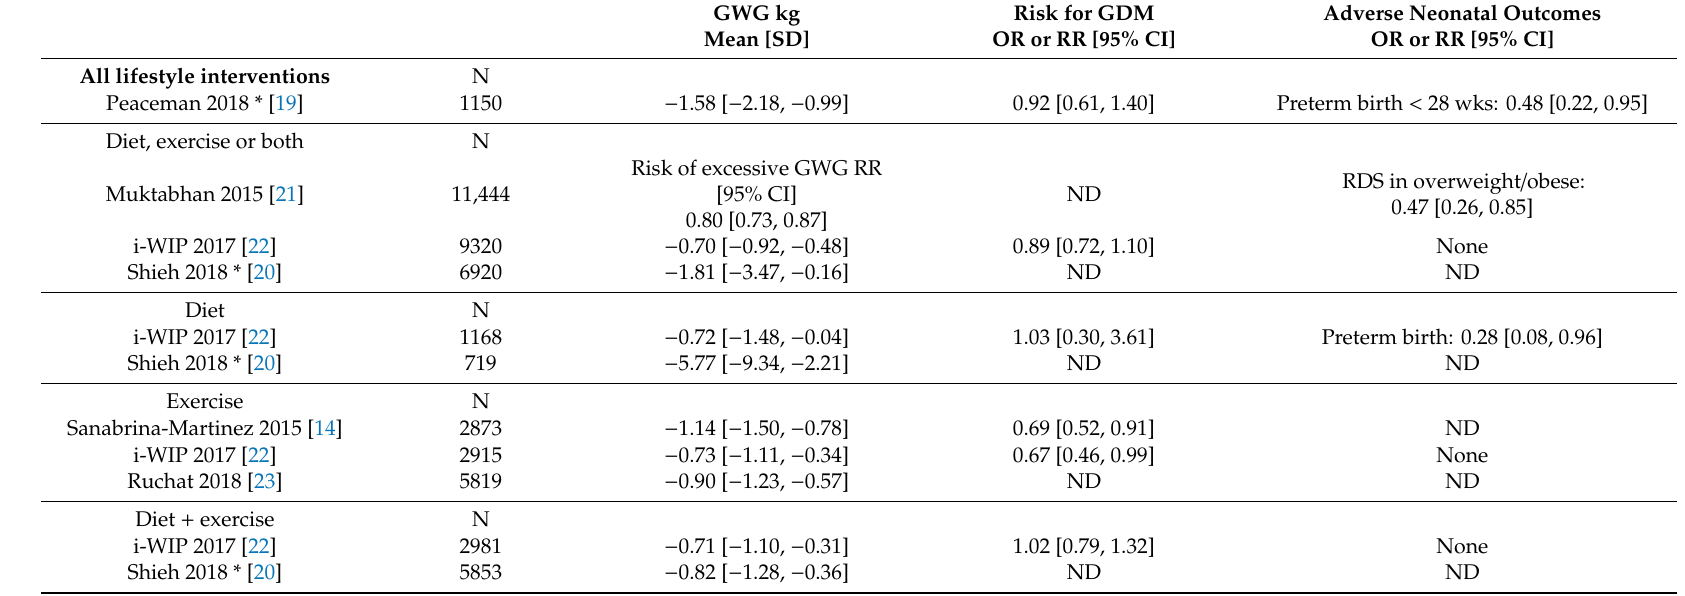
Table 2. E ff ects of lifestyle interventions on gestational weight gain (GWG) and the risk of gestational diabetes (GDM), and the risk of adverse neonatal outcomes according to meta-analyses. Only significant e ff ects on adverse neonatal outcomes are reported in the table. RDS: respiratory distress syndrome. ND: not